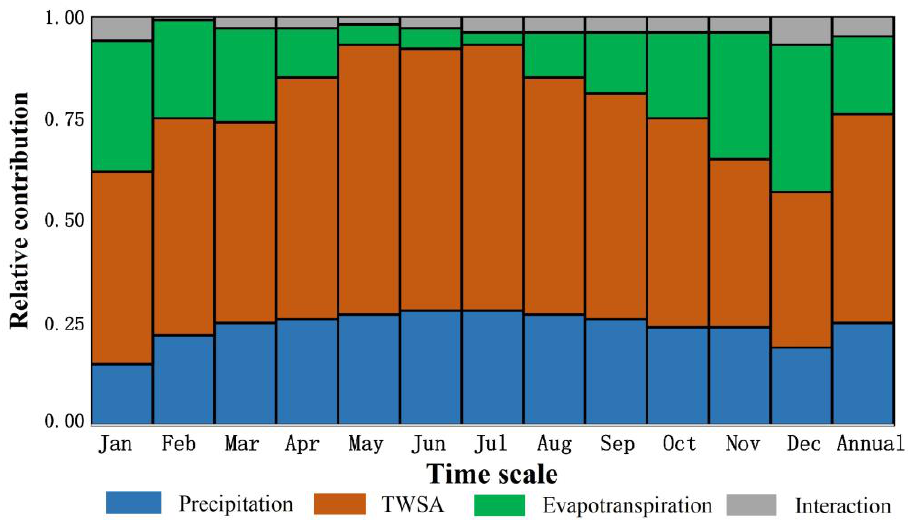
Figure 3. Spatial distribution of the average standard deviation of runoff from ( a ) GRAFO and ( b ) GLDAS, ( c ) TWSA, ( d ) precipitation, and ( e ) evapotranspiration in the Yangtze River basin between July 2018 and October 2020.